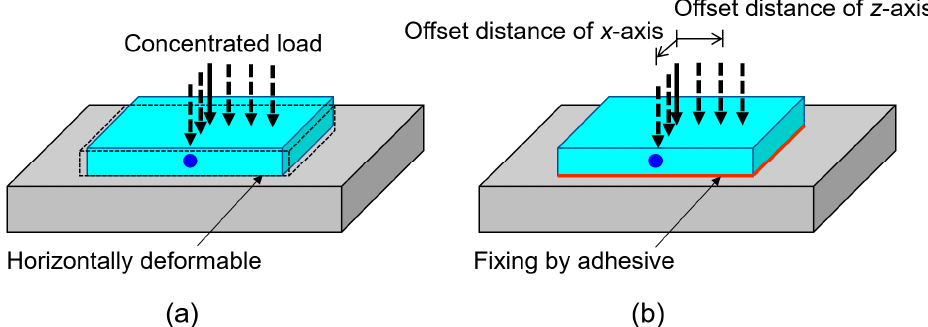
Figure 2. Illustration of the model with ( a ) center point fixed and ( b ) whole surface fixed. Table 1. Material properties of PZT.